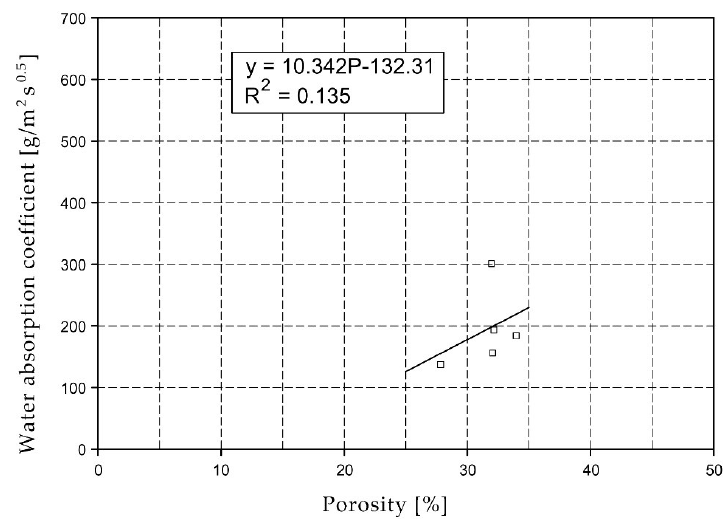
Figure 6. Compressive strength of O01XX series bricks.